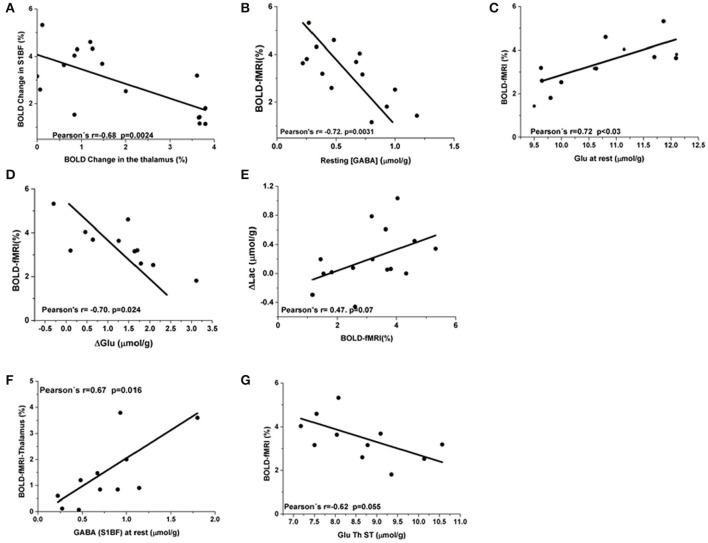
BOLD responses correlations to [Glu] and [GABA] in S1BF. (A) Negative correlation of Blood Oxygen Level dependent percent changes between the barrel cortex and the thalamus (Pearson's r = −0.68; p = 0.0024). (B) BOLD changes in the barrel cortex were negatively correlated to resting GABA levels (Pearson's coefficient = −0.72, p = 0.003). (C) A positive correlation between Glu levels at rest and BOLD responses was observed (Pearson's coefficient = 0.72, P < 0.03). (D) ΔGlu were negatively correlated to ΔBOLD (Pearson's coefficient = −0.70. P = 0.024). (E) A trend toward positive correlation between BOLD changes and Lac changes was also found (Pearson's r = 0.47; P = 0.07). Thalamic and S1BF BOLD responses correlations to [Glu] and [GABA]. In the thalamus, GABA levels were not correlated to thalamic BOLD responses neither at rest nor during activation. (F) At rest S1BF GABA levels demonstrated a positive interaction with thalamic BOLD approaching significance (Pearson's r = 0.67 and P = 0.02). (G) A negative correlation between S1BF BOLD and [Glu] during stimulation also approached significance (Pearson's r = 0.62 and P = 0.055).